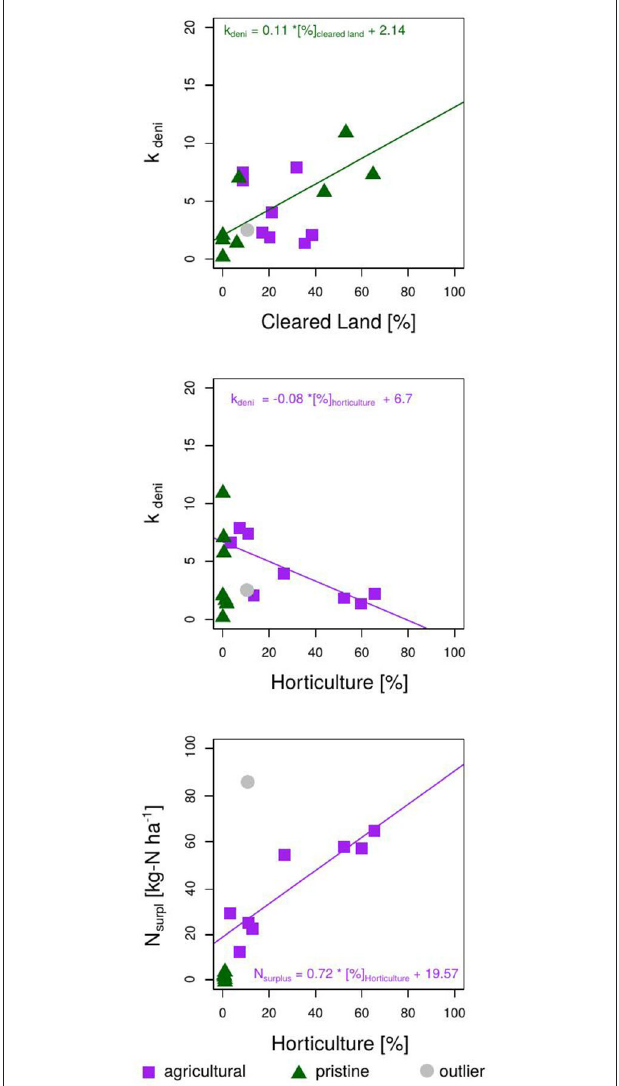
FIGURE 5 | Result of the model calibration showing the optimum model parameters N surpl and k deni for the 17 Bucca Bucca catchments. (Top) Linear correlation of k deni with percentage cleared land. Middle: Linear correlation of k deni and percentage horticulture. (Bottom) Linear correlation of N surpl and percentage horticulture. Control catchments are indicated in green (pristine = no horticulture) and show lower N surpl , than agricultural catchments (catchments with horticulture), indicated in purple. The pristine Bucca Bucca creek EC is indicated in gray; Creek NO x occurrence was delayed by multiple days, which resulted in erroneous model results, hence was not included in any regression analysis and is called Outlier